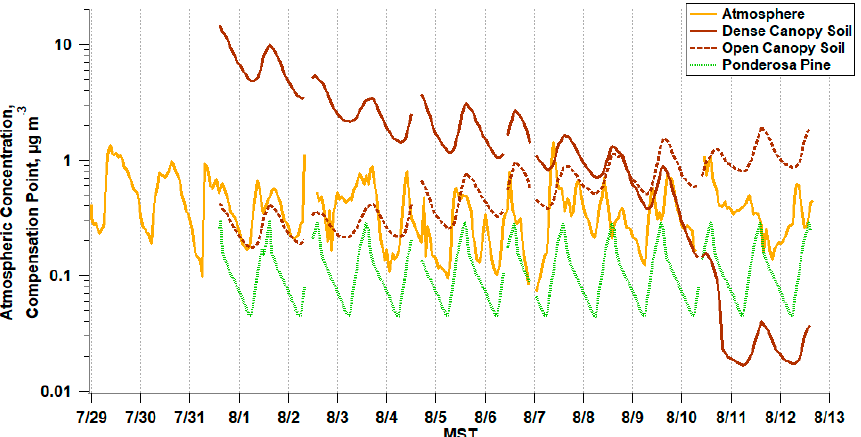
Figure 5. Change in soil and stomatal compensation points with respect to atmospheric NH 3 concentrations measured by the AIM-IC from 31 July to 13 August 2015.